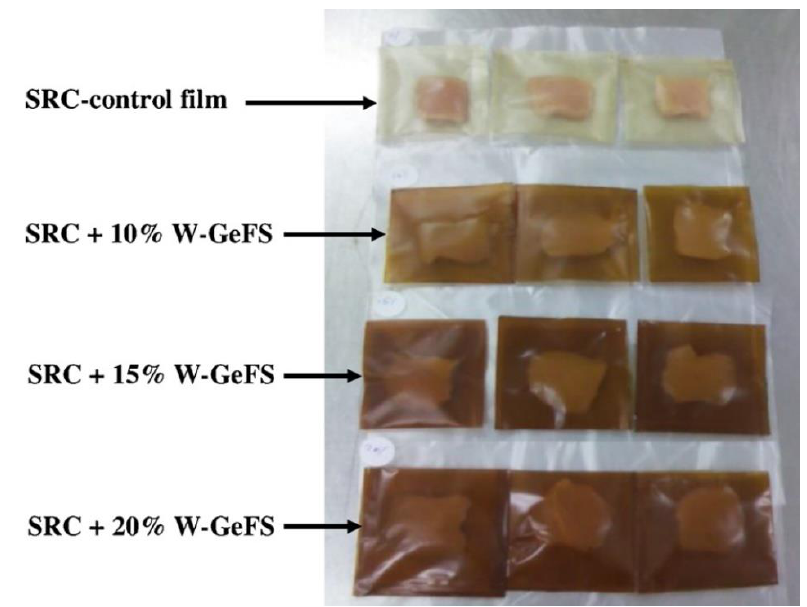
Figure 1. Photographs of chicken breast samples packed with the selected SRC films at 0 day. SRC: semirefined κ-carrageenan; W-GeFS: water extract of germinated fenugreek seeds. Reproduced with permission from [8]. (Copyright 2020 Elsevier).